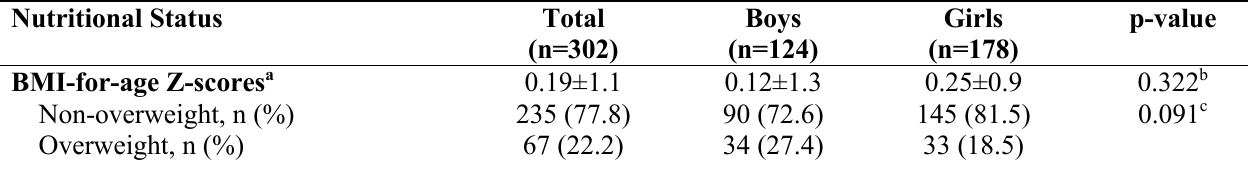
Table 3 . Nutritional status of the subjects Nutritional Status BMI-for-age Z-scores a Non-overweight, n (%) Overweight, n (%)